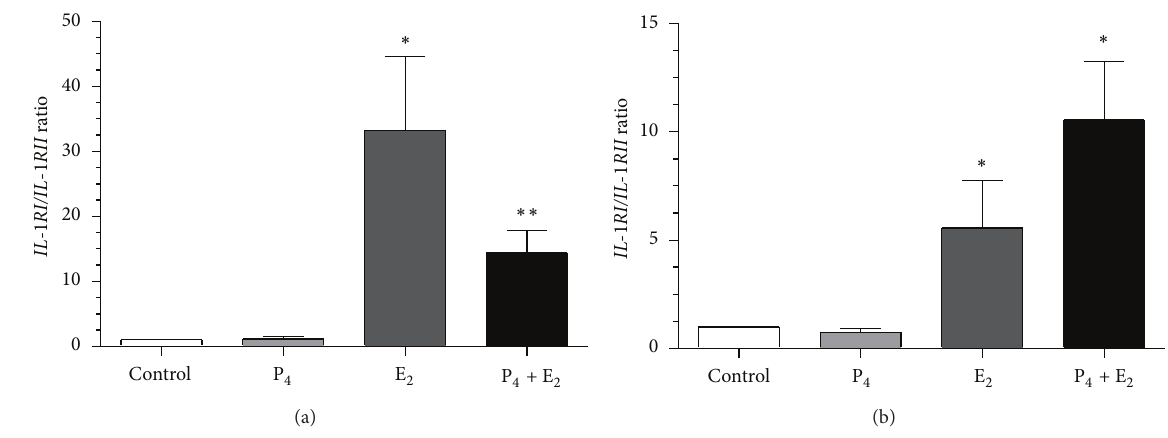
Figure 7: The effect of P 4 (10 −7 M), E 2 (10 −9 M), and P 4 + E 2 (10 −7 /10 −9 M) on IL-1RI:IL-1RII mRNA transcription ratio in epithelial cells ((a); 𝑛 = 5 ) and stromal cells ((b); 𝑛 = 5 ) after 24 h incubation. Results are normalized against ACTB. Asterisks indicate significant differences ( ∗ 𝑃 < 0.05 ; ∗∗ 𝑃 < 0.01 ) from the respective control, as determined by nonparametric one-way ANOVA Kruskala - Wallisa followed by Dunns’a test